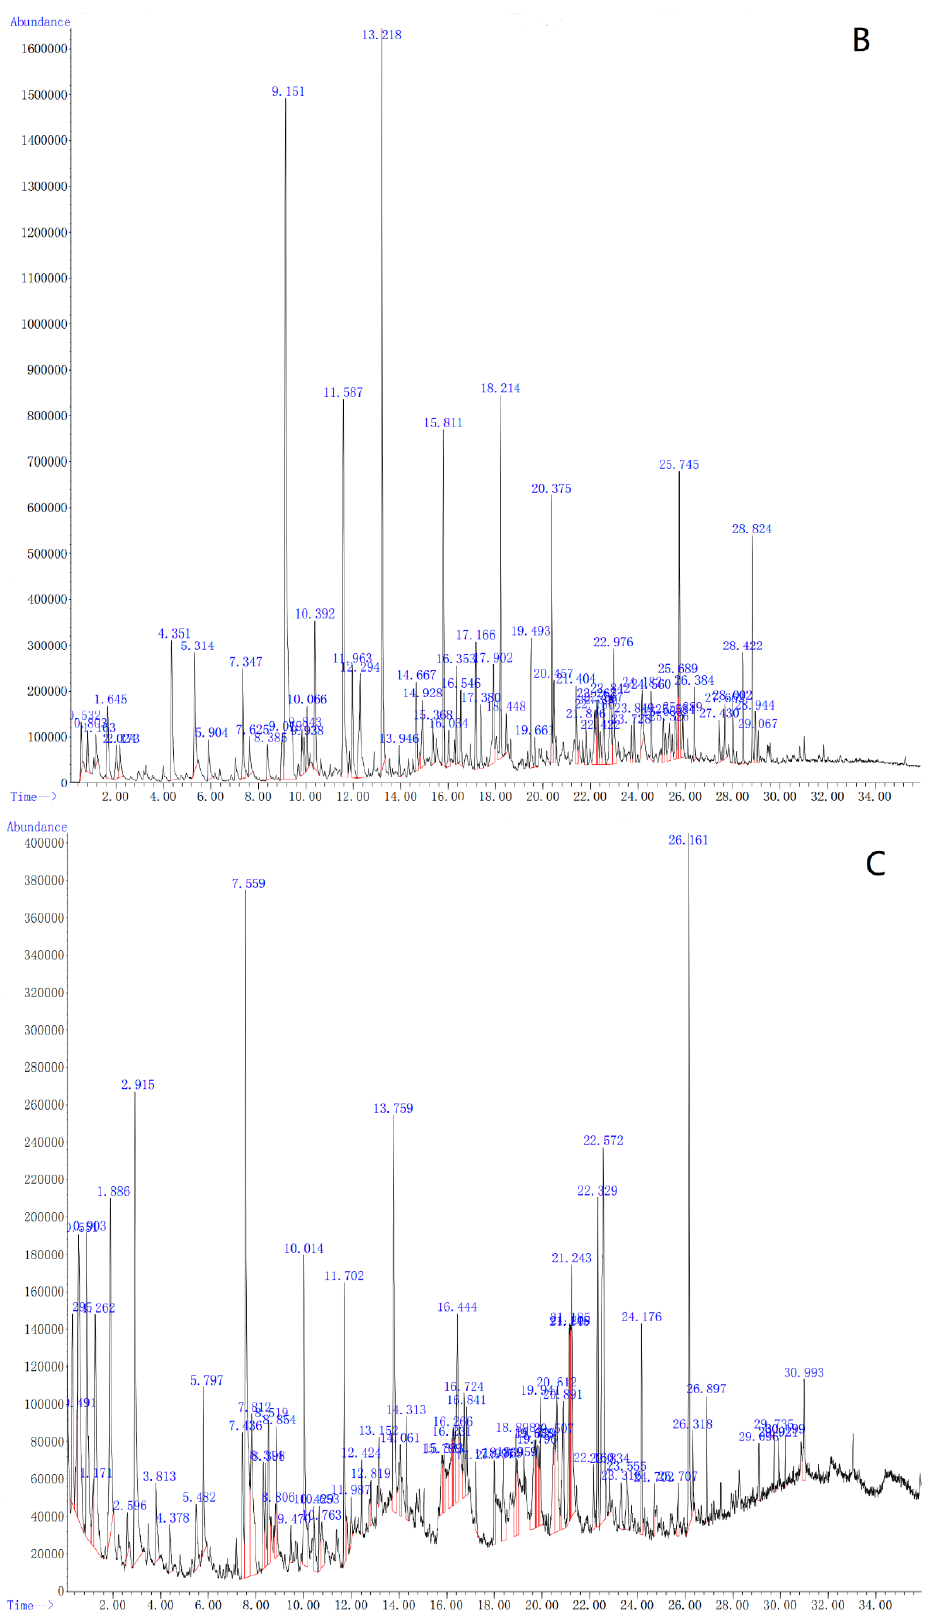
Figure 2. Volatile matters in soil. ( A ) Blank soil samples; ( B ) ZK7; ( C ) ZK7+B16.ZK7+B16: the supernatant of B. nematocida B16 was mixed with the spore suspension of P. chlamydosporia ZK7 in a ratio of 1:7 (total volume: 100